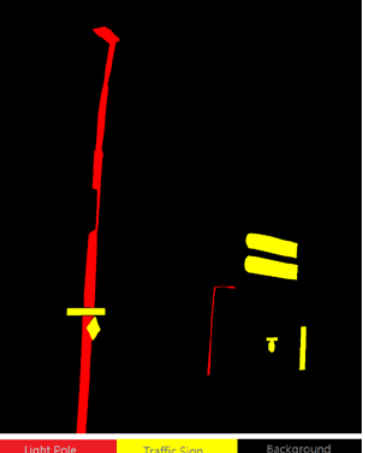
Figure 9. An example of annotation of object of interest. Light poles are in red and traffic signs are in yellow. Background is in